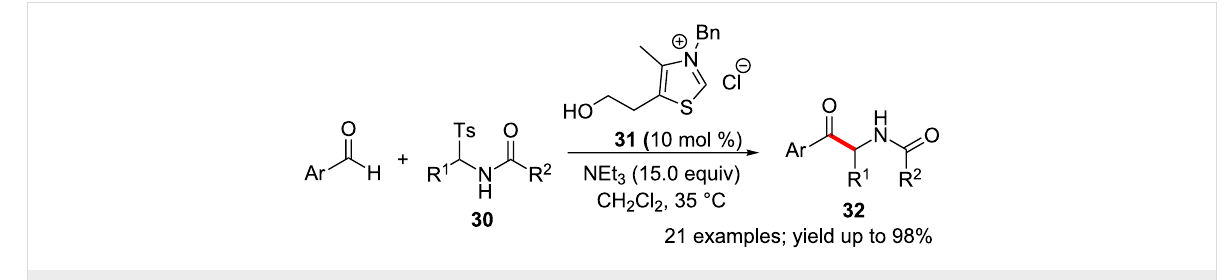
Scheme 18: Aza-benzoin reaction of aldehydes and acylimines.